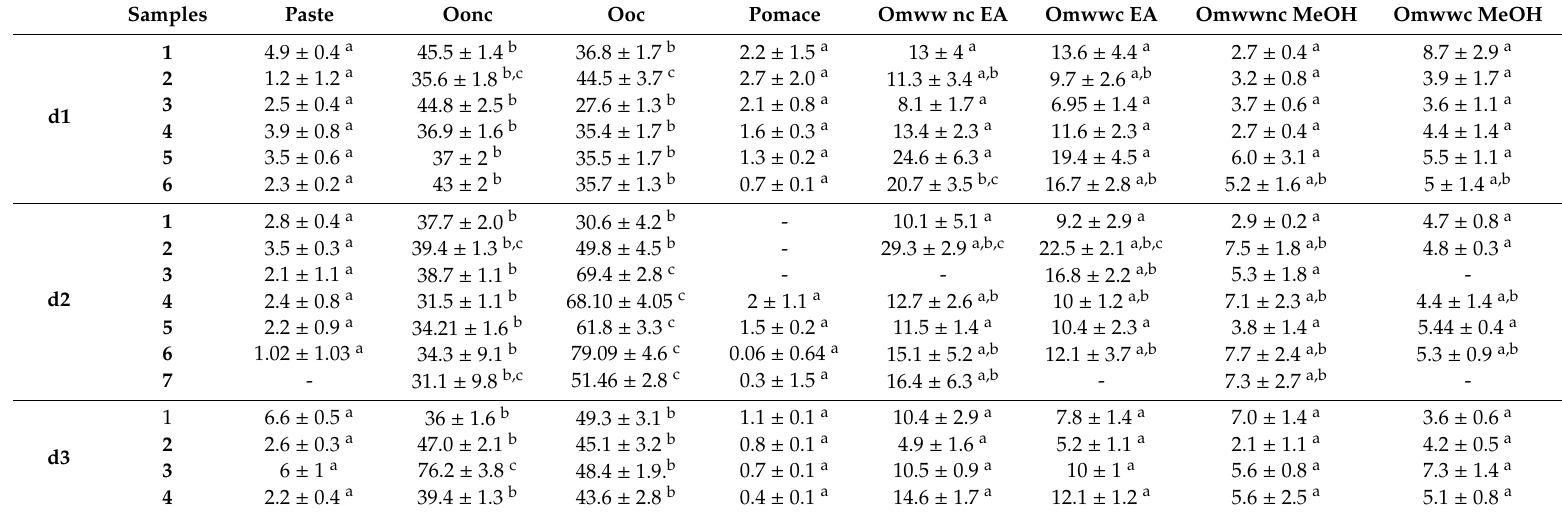
Table 3. Total polyphenols in olive oil, paste, pomace, and omww extracts (expressed as % GAE per extract).